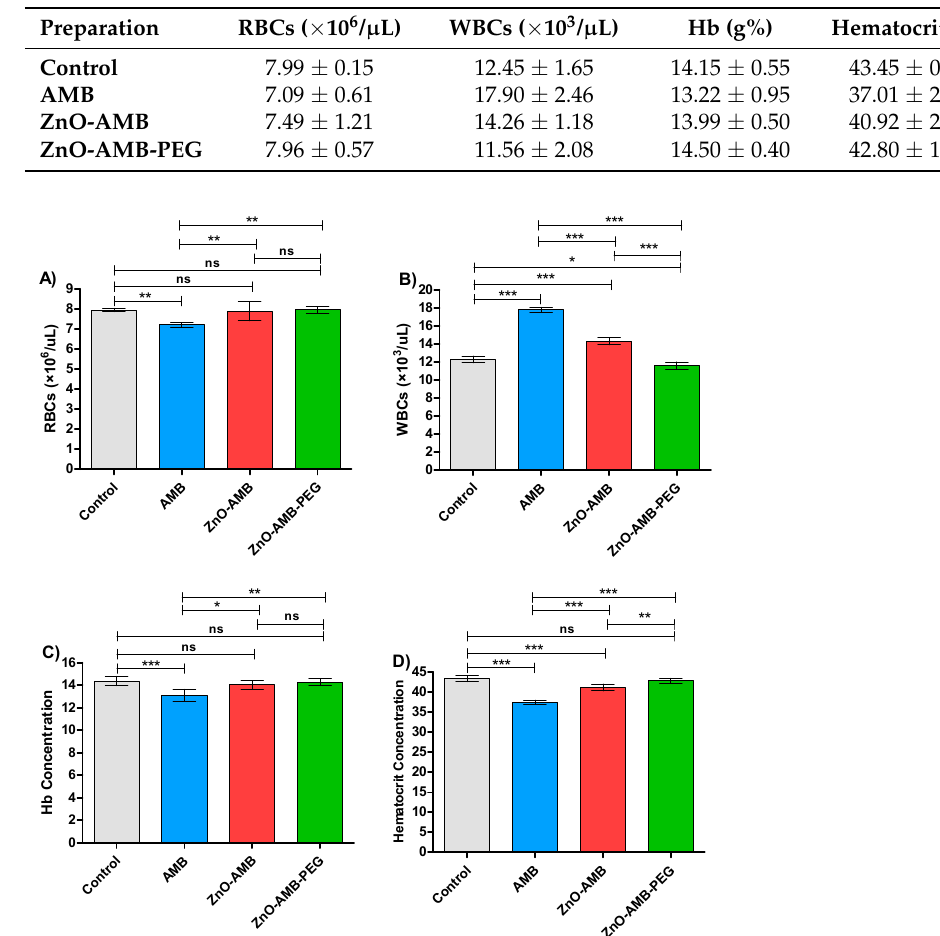
Figure 6. Hematological parameters. Four groups of rats ( n = 5) were injected intraperitonially with 10 mg/kg seven doses of free AMB, ZnO-AMB or ZnO-AMB-PEG or kept uninjected, then hematological parameters were evaluated (A; RBCs concentration, B; WBCs concentration, C; Hb concentration, D; Hematocrit concentration). The assays were conducted in triplicate and one-way ANOVA test followed by Tukey’s multiple comparison post hoc test were used to attest the significance. The PEGylated ZnO-AMB did not show any significant difference in hematological parameters in comparison to control group levels, except ZnO-AMB-PEG significantly increased the WBCs in comparison to control group. Furthermore, ZnO-AMB-PEG significantly decreased the WBCs count and hematocrit concentrations in comparison to ZnO-AMB. * = p < 0.05, ** = p < 0.01 and *** = p < 0.001, ns = non-significant.